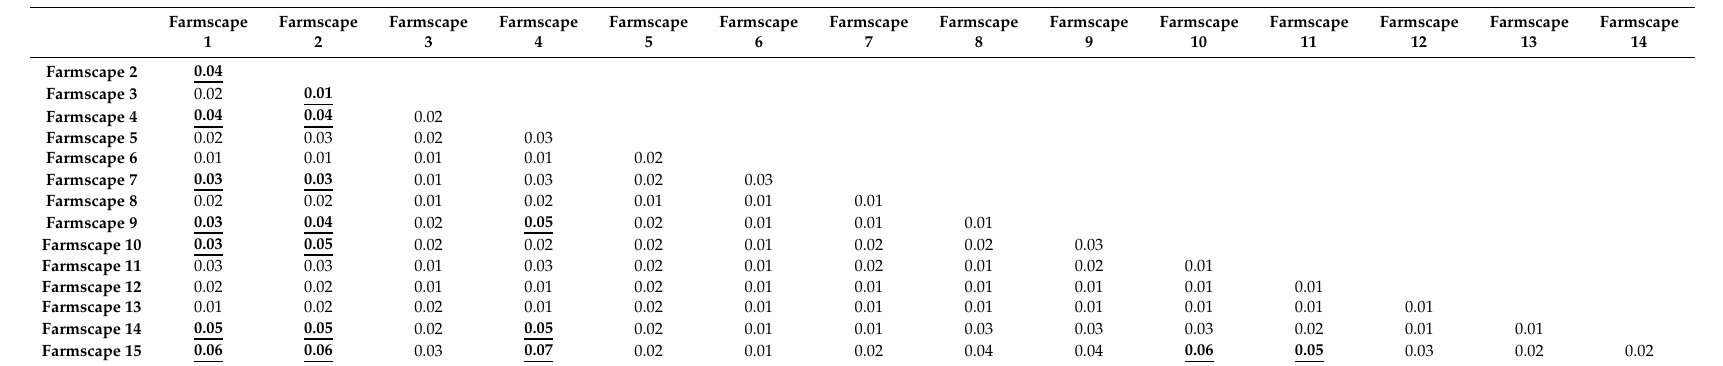
Table 8. Pairwise F ST values among B. tabaci MEAM1 populations collected from di ff erent farmscapes based on six microsatellites